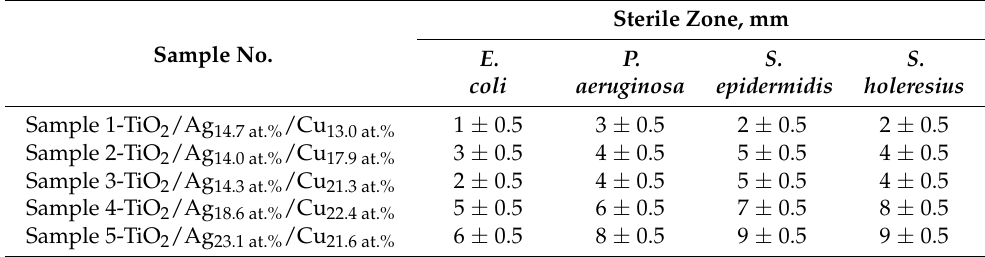
Table 3. Antimicrobial activity toward Gram-negative and Gram-positive microbial strains (as a sterile zone, mm; by agar diffusion test) of TiO 2 /Ag/Cu magnetron cosputtered thin coatings depending on the Cu-content at almost equal Ag content (Samples 1, 2, and 3) and depending on Ag content at almost equal Cu content (Samples 3, 4, and 5). Sterile Zone, mm Sample No. E. P. S. S. coli aeruginosa epidermidis holeresius Sample 1-TiO 2 /Ag 14.7 at.% /Cu 13.0 at.% 1 ± 0.5 3 ± 0.5 2 ± 0.5 2 ± 0.5 Sample 2-TiO 2 /Ag 14.0 at.% /Cu 17.9 at.% 3 ± 0.5 4 ± 0.5 5 ± 0.5 4 ± 0.5 Sample 3-TiO 2 /Ag 14.3 at.% /Cu 21.3 at.% 2 ± 0.5 4 ± 0.5 5 ± 0.5 4 ± 0.5 Sample 4-TiO 2 /Ag 18.6 at.% /Cu 22.4 at.% 5 ± 0.5 6 ± 0.5 7 ± 0.5 8 ± 0.5 Sample 5-TiO 2 /Ag 23.1 at.% /Cu 21.6 at.% 6 ± 0.5 8 ± 0.5 9 ± 0.5 9 ± 0.5